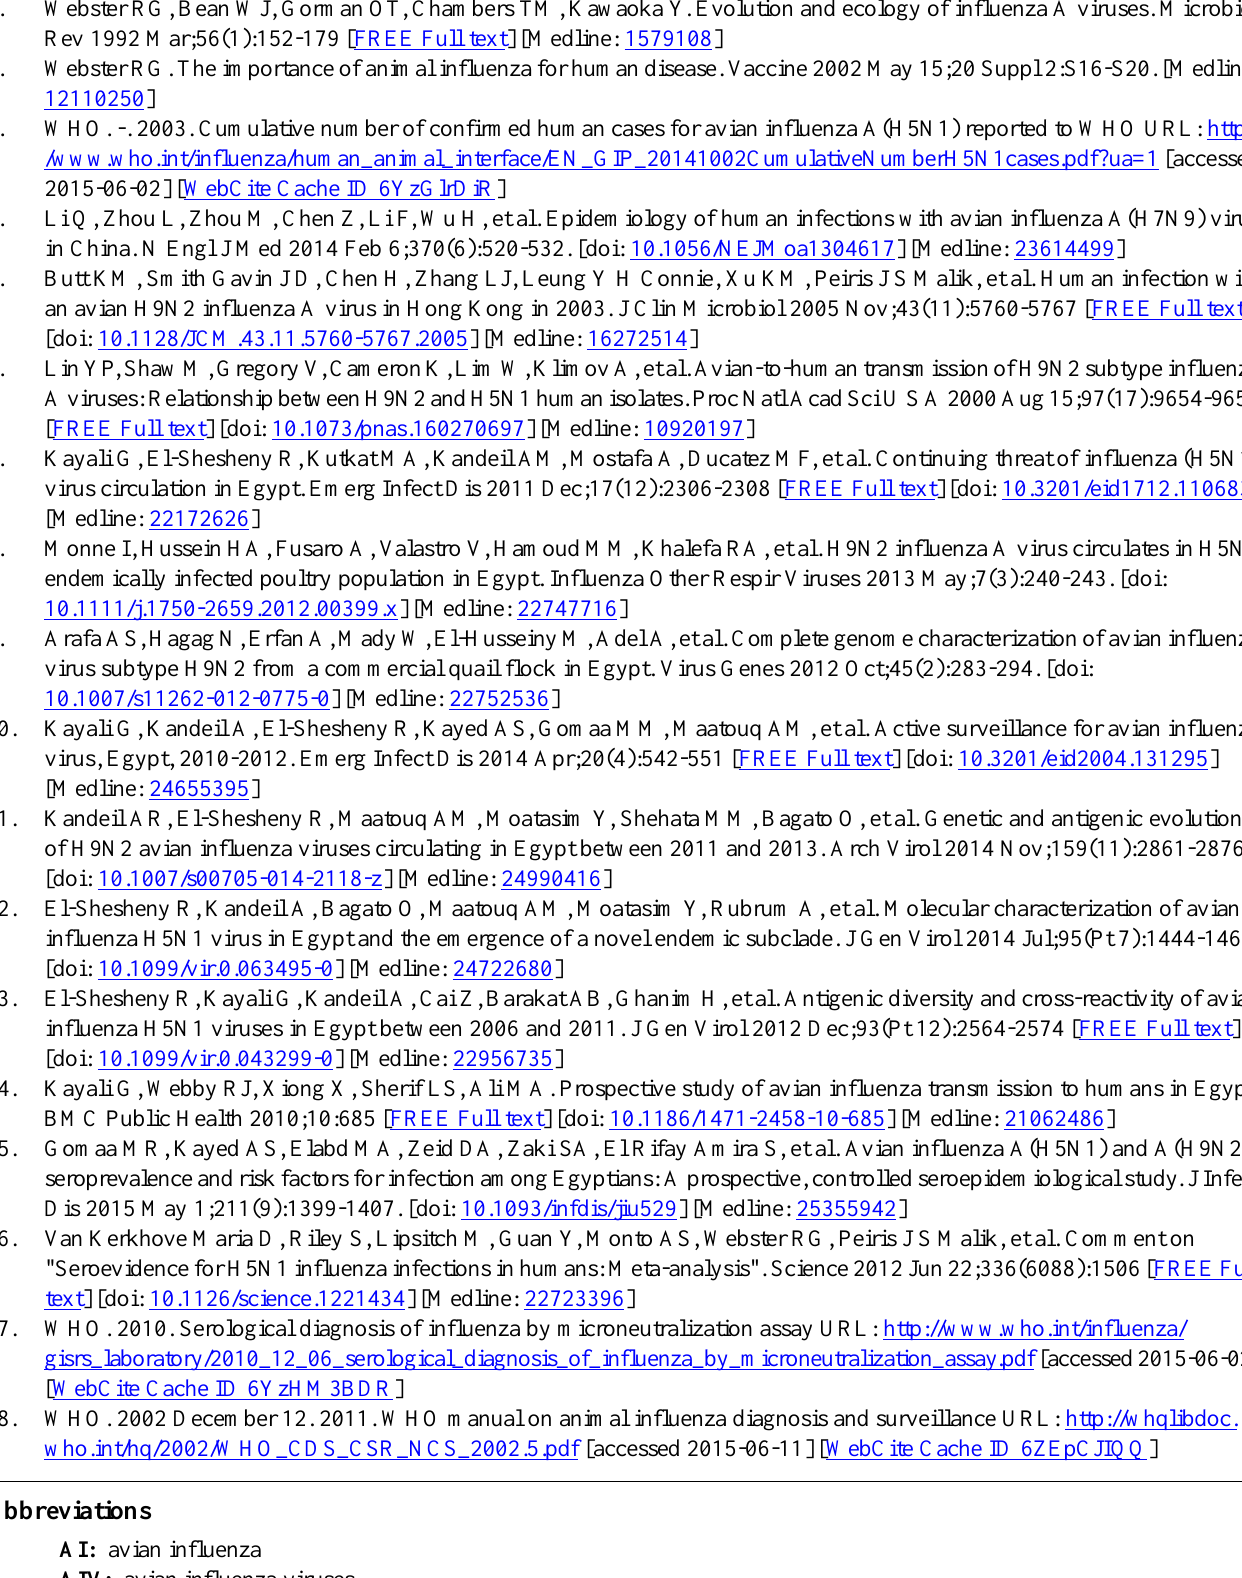
AI: avian influenza AIV: avian influenza viruses ILI: influenza-like illness symptoms ml: milliliters PBMC: peripheral blood mononuclear cells PCR: polymerase chain